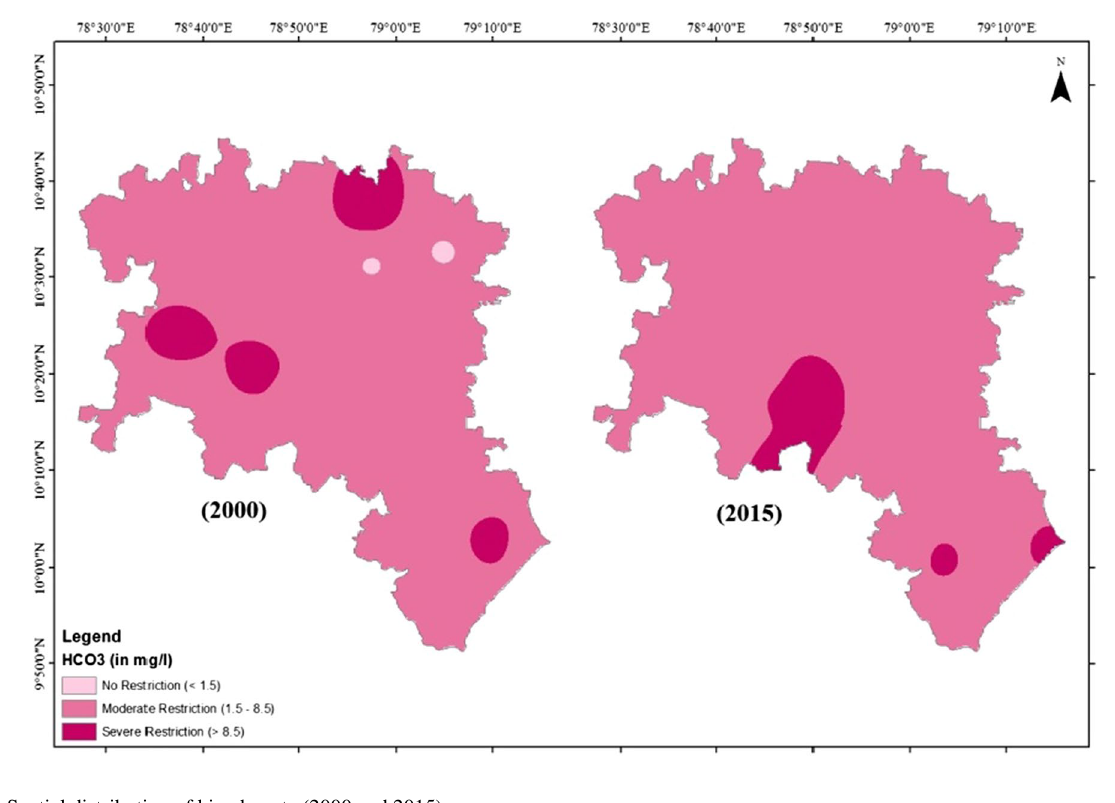
Fig. 6 Spatial distribution of bicarbonate (2000 and 2015)